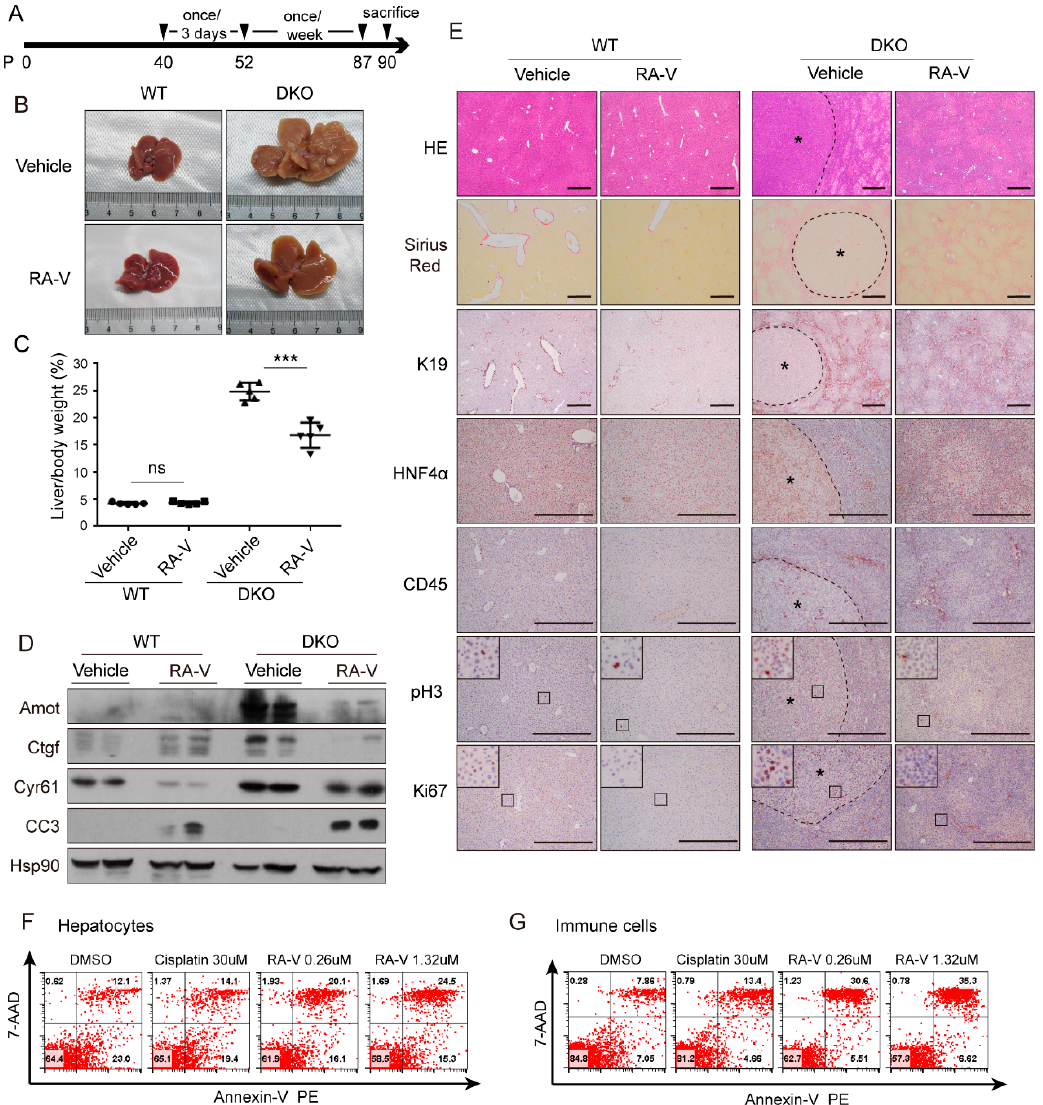
Figure 5. RA-V inhibits liver tumorigenesis in Mst1/2 double knockout mice. ( A ) Schedule of RA-V (10 mg/kg) injection. ( B , C ) RA-V inhibits tumorigenesis in Mst1/2 DKO mice. Images are representative of five mice ( B ). The live/body weight ratios were quantified ( C ) and values represent mean ± SD with all data points plotted. p values were determined by Student’s t test. ns, not significant; ***, p < 0.001. ( D ) RA-V represses protein levels of YAP target genes and promotes apoptosis in Mst1/2 DKO livers. Two representative livers from each group were analyzed by western blotting. ( E ) Pathological and IHC staining of liver sections from ( B ). Results are representative of five mice. Scale bars, 500 µ m. Asterisks denote tumors. ( F , G ) RA-V induces apoptosis of hepatocytes ( F ) and immune cells ( G ) isolated from tumors of Mst1/2 DKO livers. Tumors were digested and fractionated by density gradient centrifugation. Respective cells were cultured in vitro for 12 h with DMSO, RA-V or cisplatin as indicated. Cells were then analyzed by flow cytometry. Experiments were duplicated.